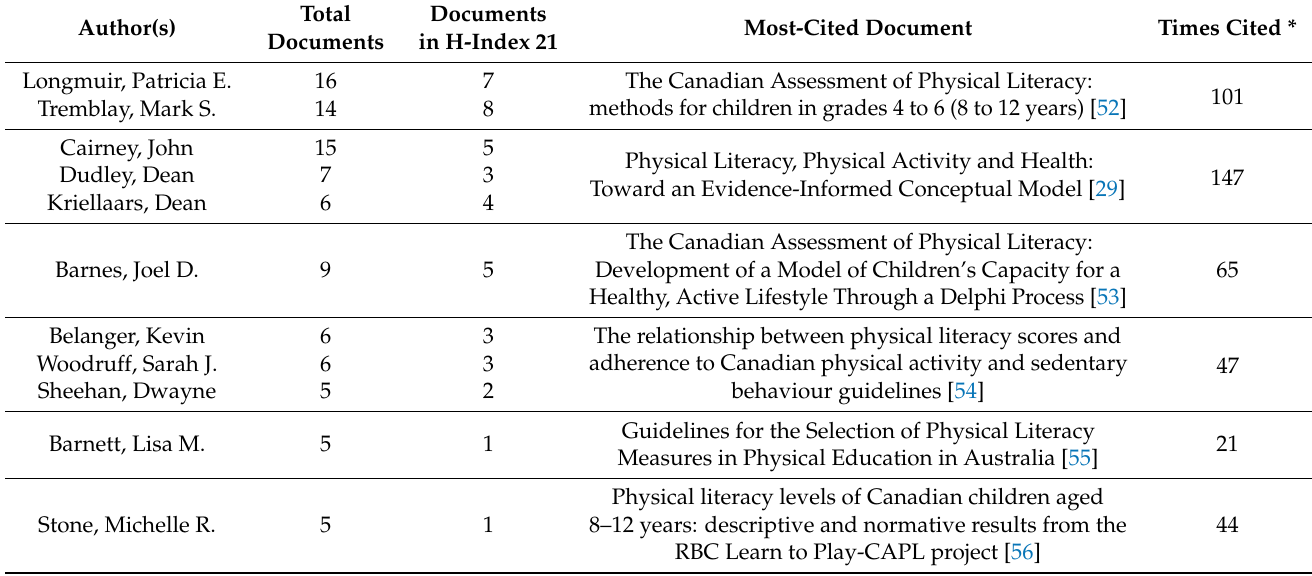
Table 4. Prominent Table 4. Prominent Co-authors.